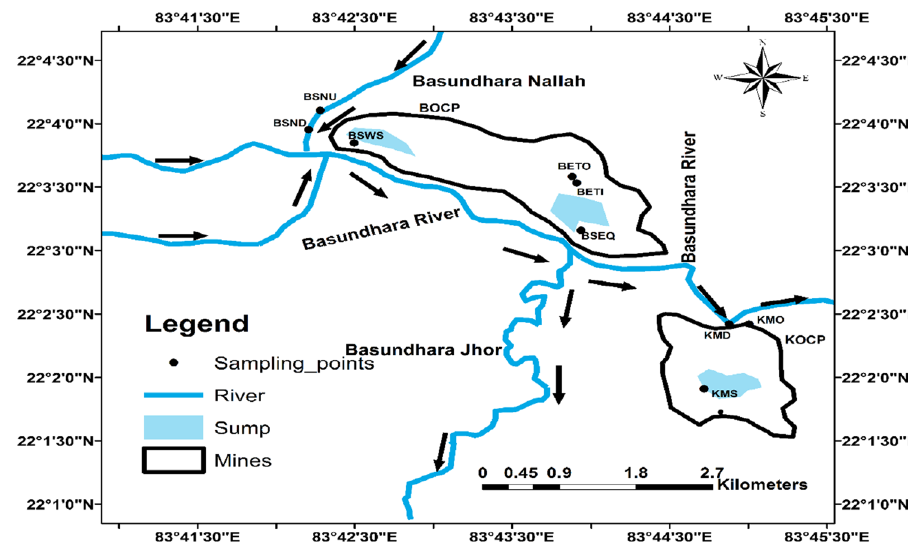
Fig. 5 Map showing Basund- hara area with location of sampling